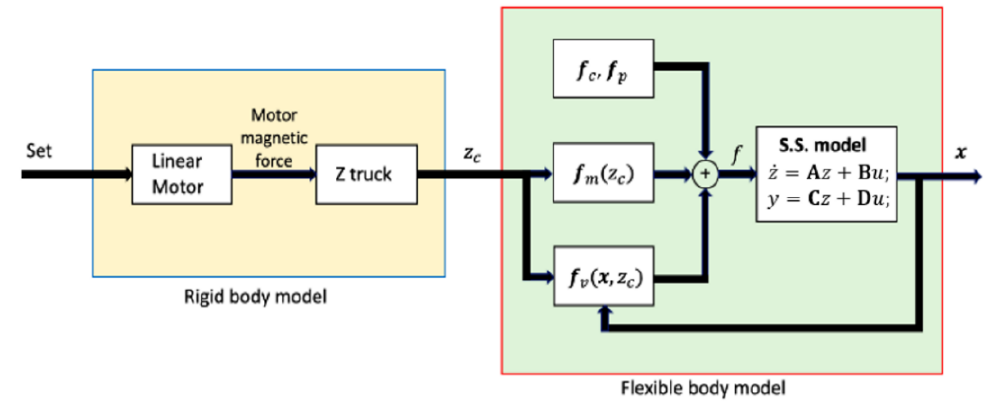
Figure 2. Schematic representation of the model.